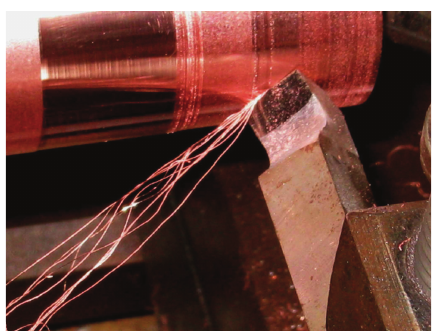
Figure 2: In situ photo of copper fiber